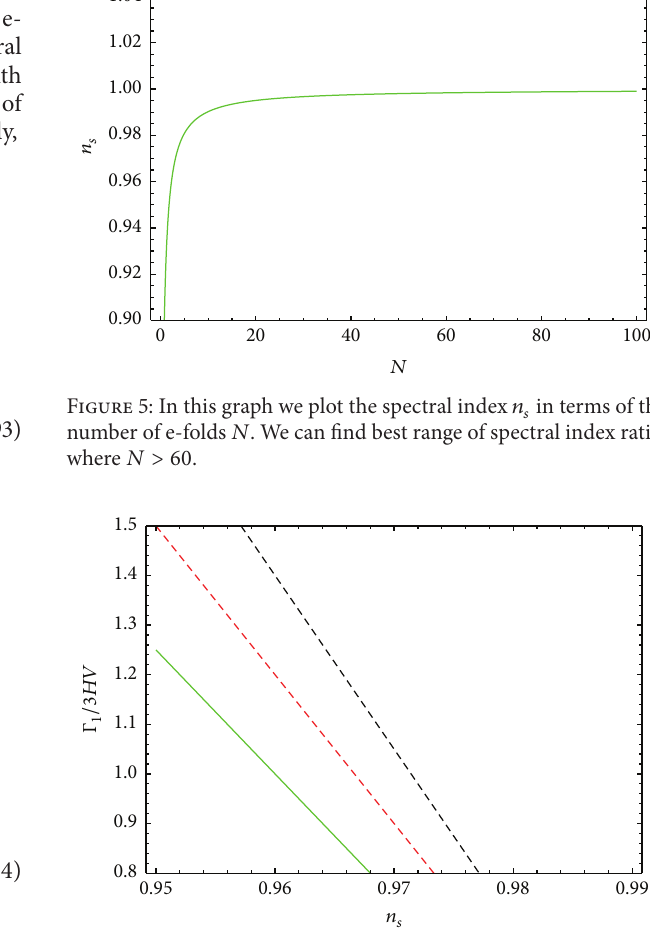
Figure 6: In this graph we plot the dissipation to Hubble parameter ratio Γ 1 /3𝐻 in terms of the spectral index 𝑛 𝑠 . We can find best fit of high dissipative regime Γ 0 > 3𝐻 with the Planck data for three cases of Γ 1 .